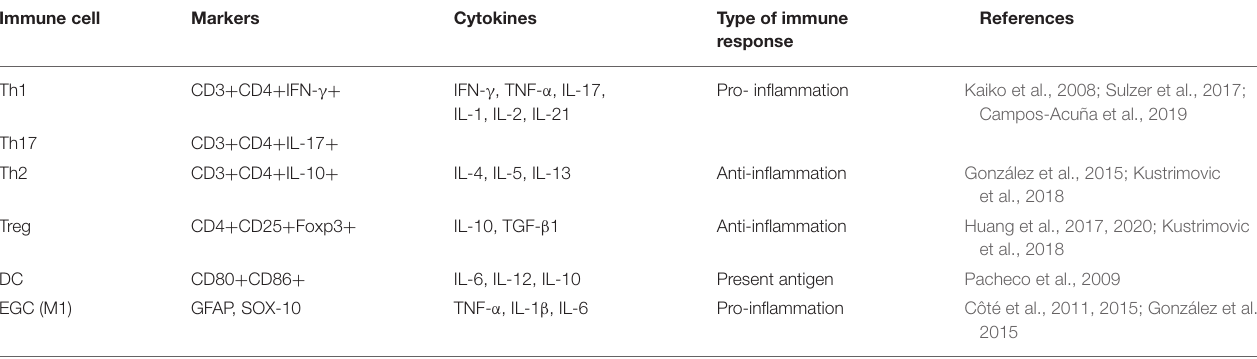
TABLE 1 | Types of gastrointestinal immune cells associated with PD and their pro-/anti-inflammatory effects. Immune